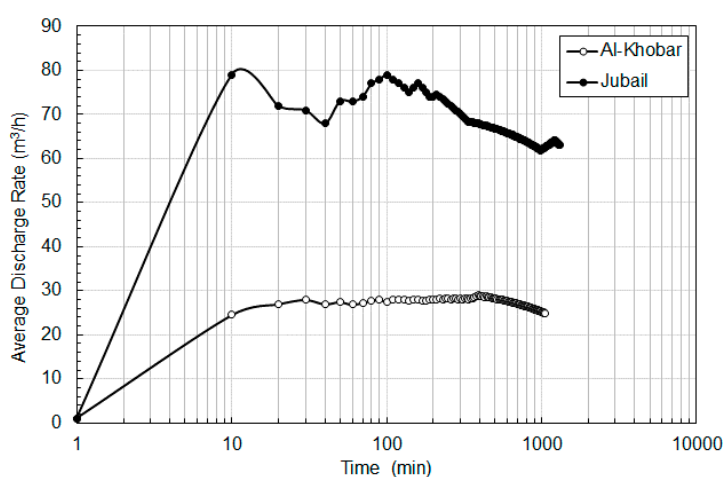
Figure 5. Average discharge from the beach wells vs. time curve for the Al-Khobar and Jubail sites.